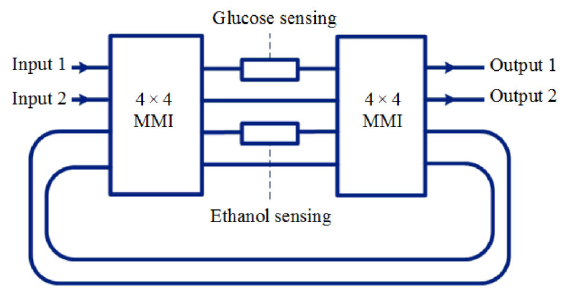
Fig. 1 Schematic of the new sensor using 4 × 4 MMI couplers and microring